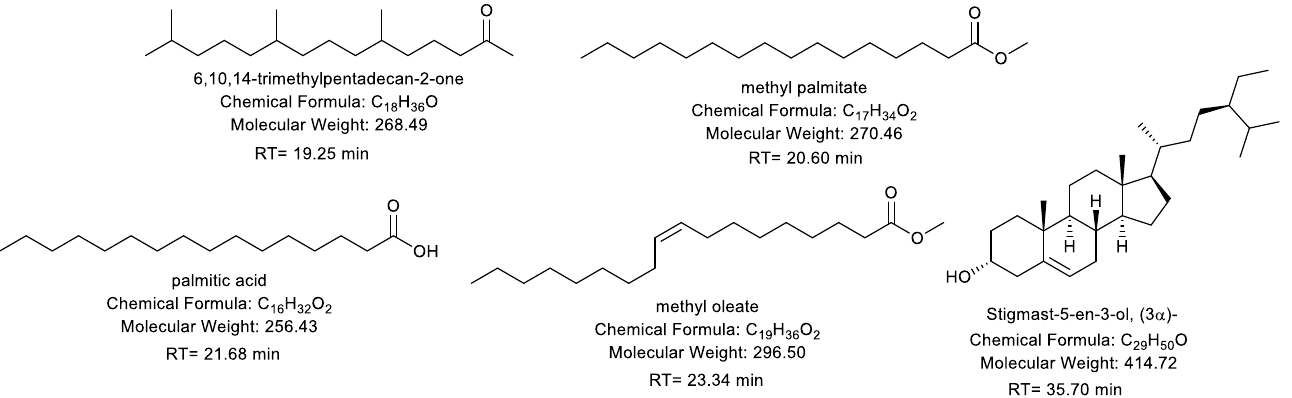
Figure 2. Chemical structure of the major identified compounds in the MeOH extract of R. tingitana . Table 1. The characterized chemical components were isolated from the extracted shoots of R. tingitana.